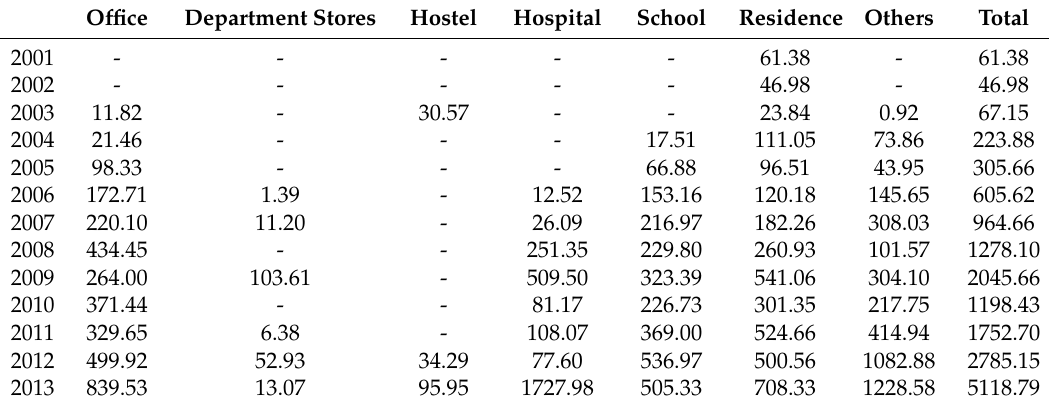
Figure 2. The comparison of the quantity of water consumption and water savings for each category of building (2000–2013) (unit: ×10 3 m 3 ). Table 4. The quantities of gross water saving for each category of building (unit: ×10 3 m 3 ).